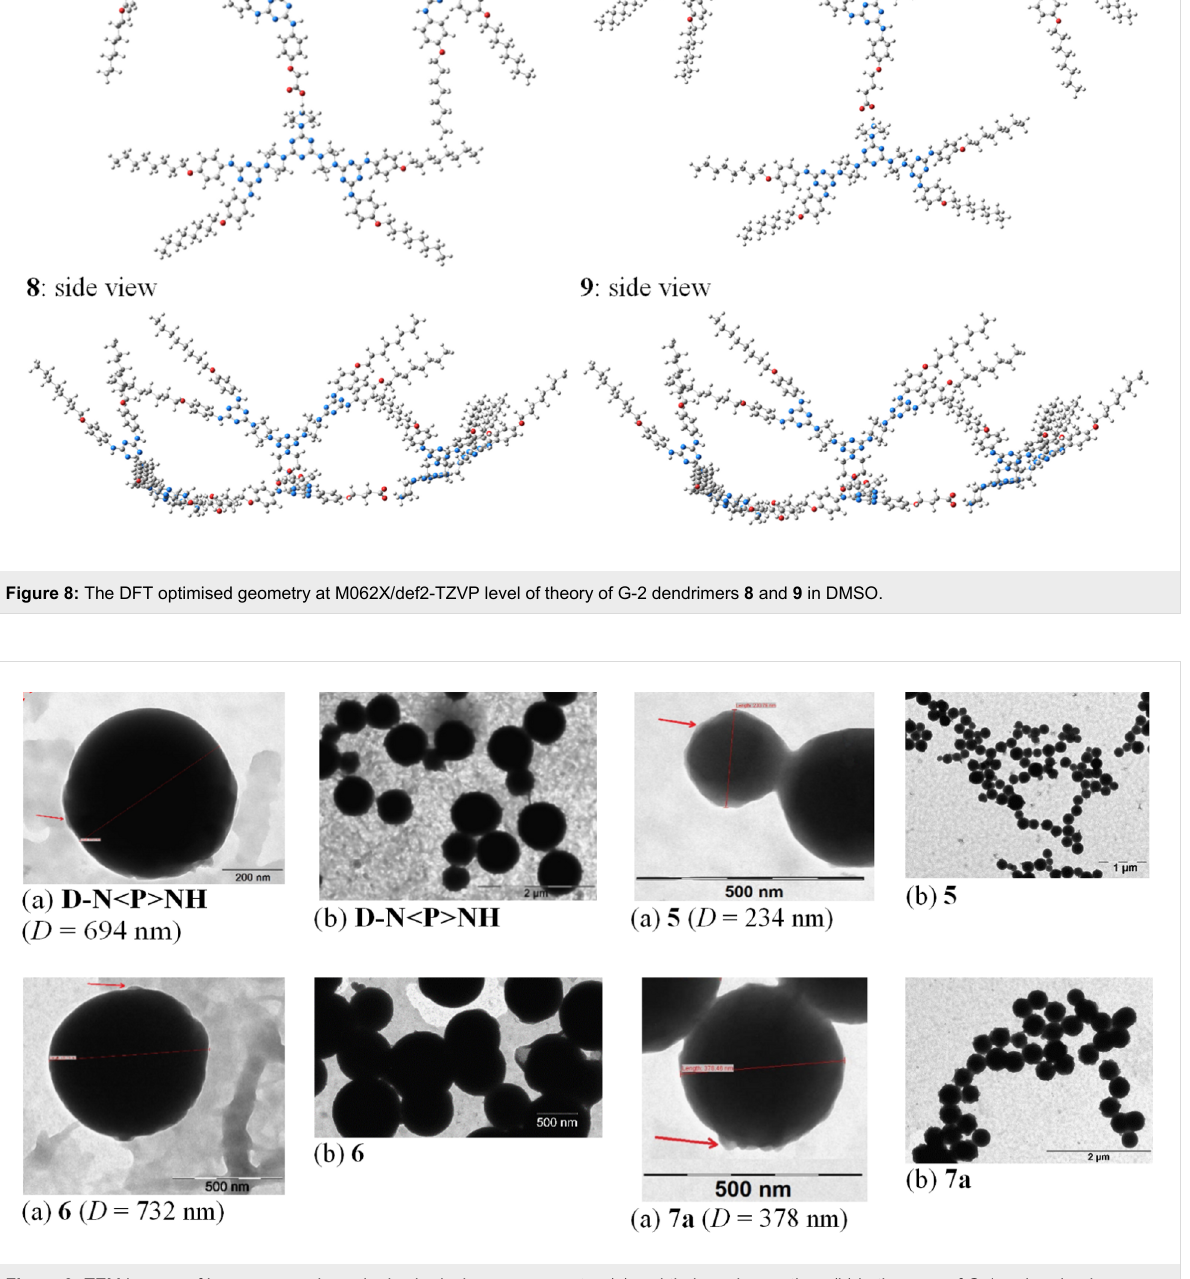
Figure 9: TEM images of homogeneously packed spherical nano-aggregates (a) and their agglomerations (b) in the case of G-1 amino-dendron D-N<P>NH and of covalent G-2 dendrimers 5–7a . D is the average diameter of nanospheres; the red arrow shows the nano-particles that